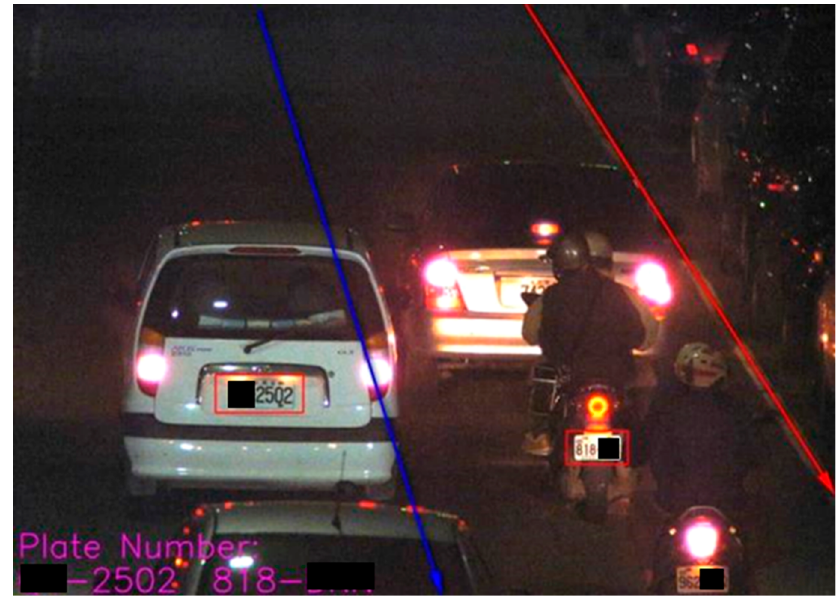
Figure 5. A schematic diagram for detecting the identification of nighttime objects.